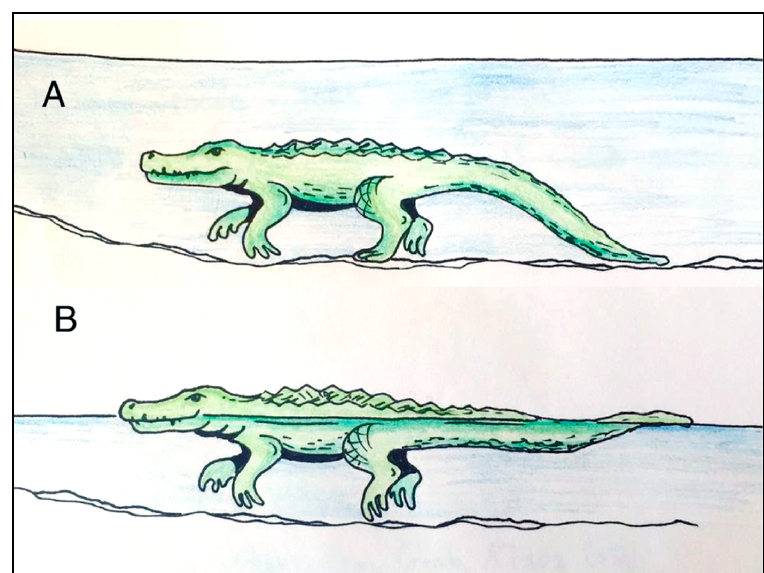
Figure 15. Locomotion patterns of crocodiles travelling in water. A . Bottom walking, with intermittent foot contact and linear tail drag, B . Swimming in shallow water, with possible intermittent foot contact and tail undulations for propulsion. Drawing by Jessie Thoreson, 2019.